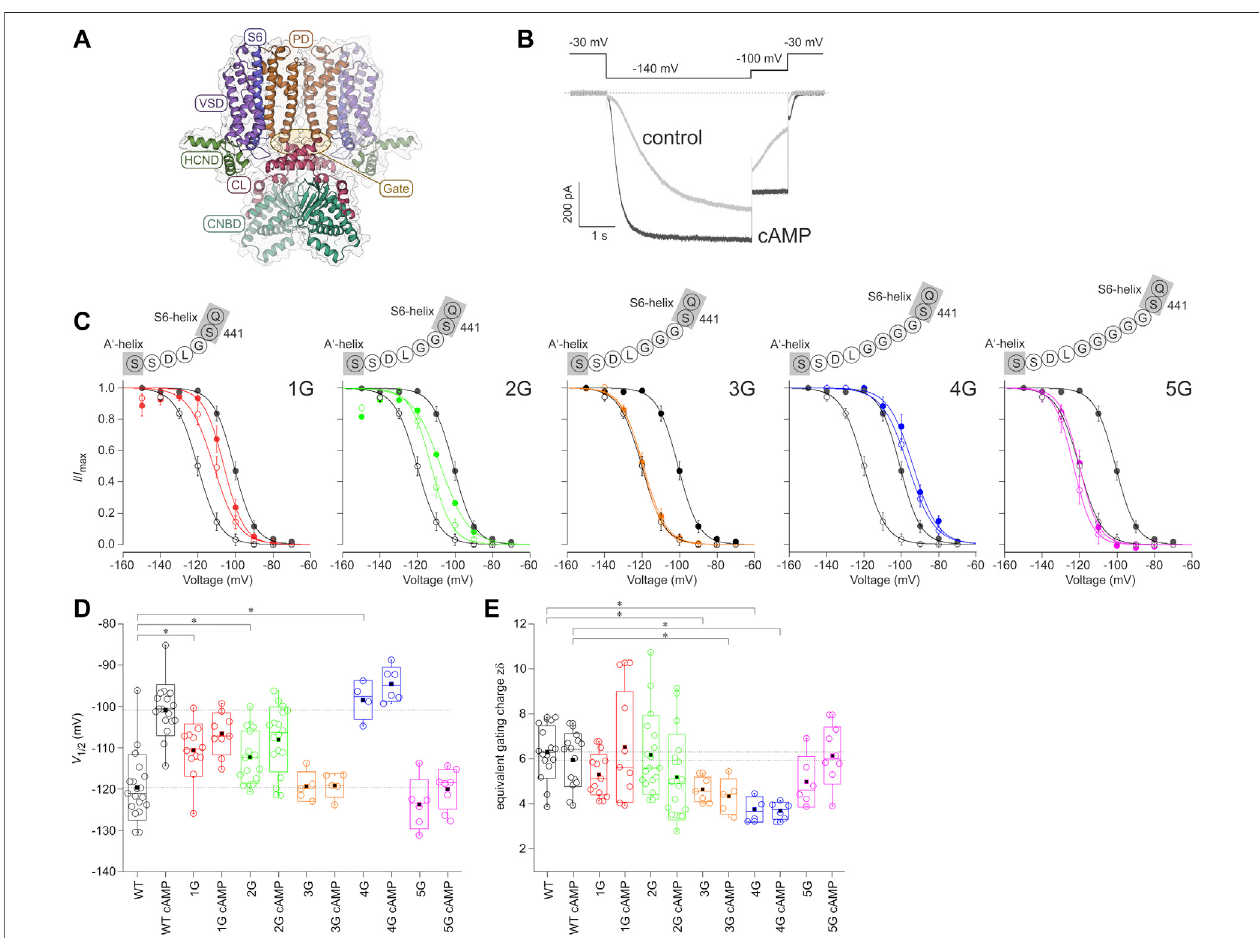
FIGURE1| Effectofinserting different numbers ofglycinesbetween S6and A ′ -helix onchannelgating. (A) Structural model ofthehomotetrameric HCN2 channel (residues L136 to D650) as a side view. The gray bars depict the approximate location of the membrane bilayer. The voltage sensor domain (VSD), pore domain (PD), C-Linker(CL), cyclicnucleotide-bindingdomain (CNBD), andHCN domain (HCND) areillustrated.Thearrow indicatesthe siteofglycineinsertion. (B) Exemplary current traces for HCN2 activation under control conditions without cAMP (grey trace) and with a saturating concentration of 10 µM cAMP (black trace). The used voltage protocol is shown above. (C) Steady-state activation relationships for all fi ve mutated constructs in comparison to HCN2. Open symbols represent control conditions without cAMP, fi lled symbols represent recordings at 10 µM cAMP ( n = 4 – 18). In all panels, black lines and symbols represent HCN2. The modi fi ed sequences are illustratedforeachconstruct. (D) Boxplotsresenting V 1/2 valueswithoutcAMPandwith10 µM cAMPwiththefollowingrepresentationsofthebox features:centerlines = medians, box limits = standard deviation, whiskers = minimum and maximum values, circles = individual recordings, squares = means. Horizontal black lines illustrate the wildtype values with and without cAMP for comparison. Signi fi cant differences are indicated by asterisks. (E) Box plot of z δ values. Box features are the same as in (D) . Signi fi cant differences are indicated by asterisks.